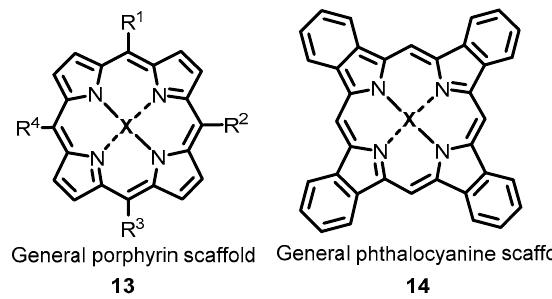
Figure 4. General scaffolds of porphyrins ( 13 ) and phthalocyanines ( 14 ).